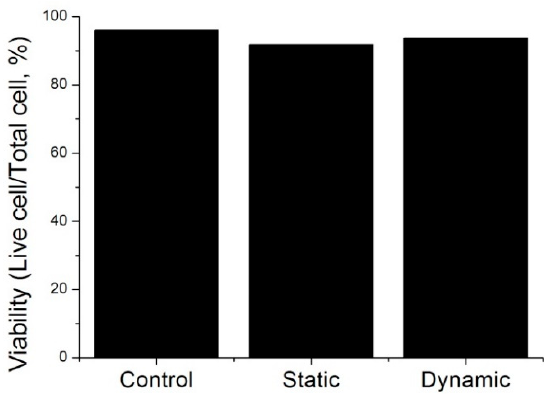
Figure 5. NIH/3T3 cell viability in three conditions. Sample size: n = 8; dimensions of the microchannel: 500 μ m (W) × 126 mm (L) × 150 μ m (H); flow rate of the dynamic culture: 4 μ L/min.